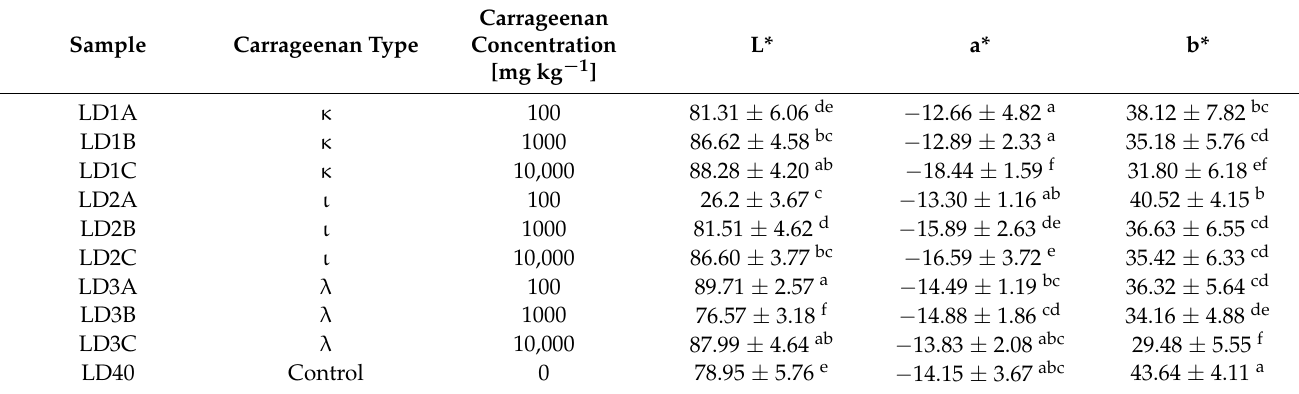
Table 3. Limit of detection for CIE L*a*b*